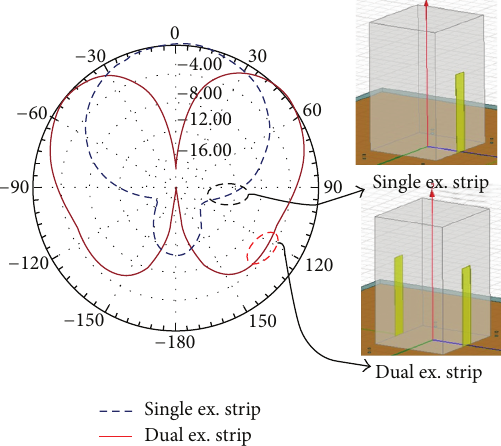
Figure 5: DRA 2D radiation pattern with single and dual strip excitation strips, without parasitic strips at 1.6 GHz, 𝑎 = 32 mm, 𝑏 = 29.6 mm, 𝑑 = 48.85 mm, 𝐿 = 25 mm and 𝑀 𝑀 1 = 5 mm, and 𝐿 = 𝑊 = 130 mm. 𝑃 𝑑